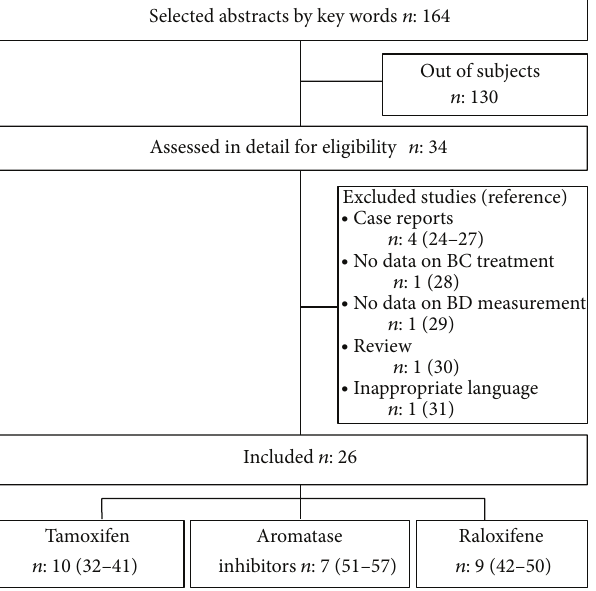
Figure 1: Flowchart illustrating movement of papers from search to